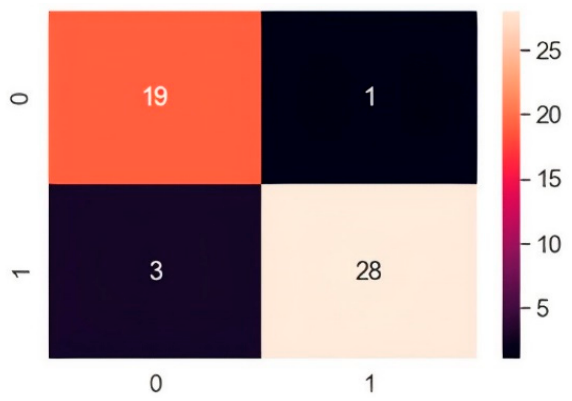
Figure 8. The confusion matrix for architecture 13. We can observe that true positive = 28, true negative = 19, false positive = 3, and false negative = 1.